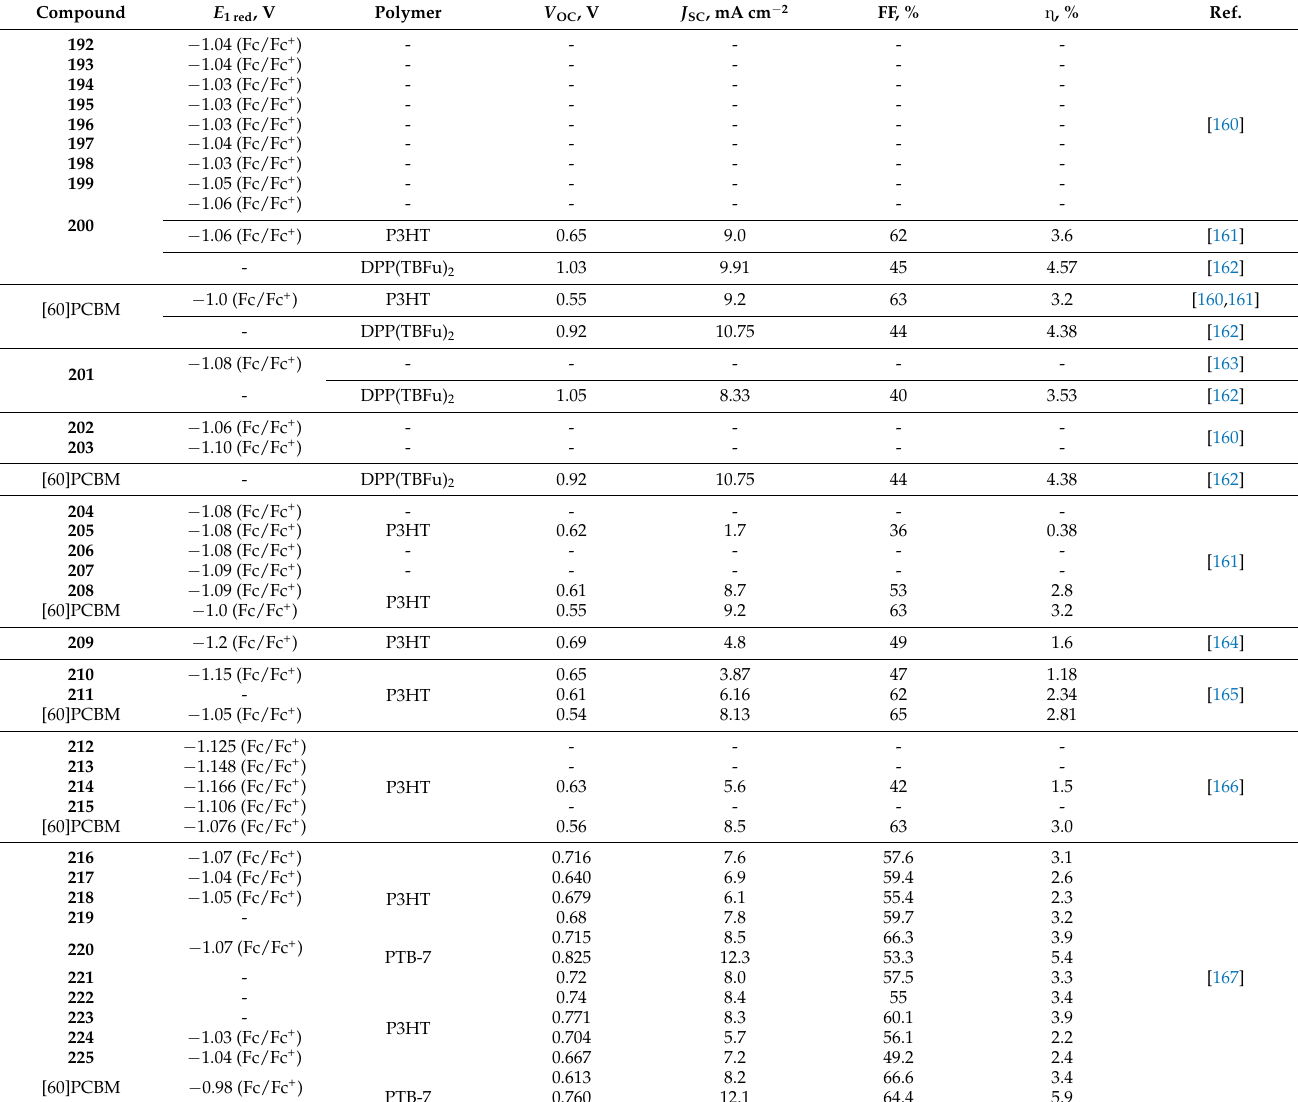
Table 6. First reduction potentials and characteristics of the solar cells based on the 1,4- fullerene